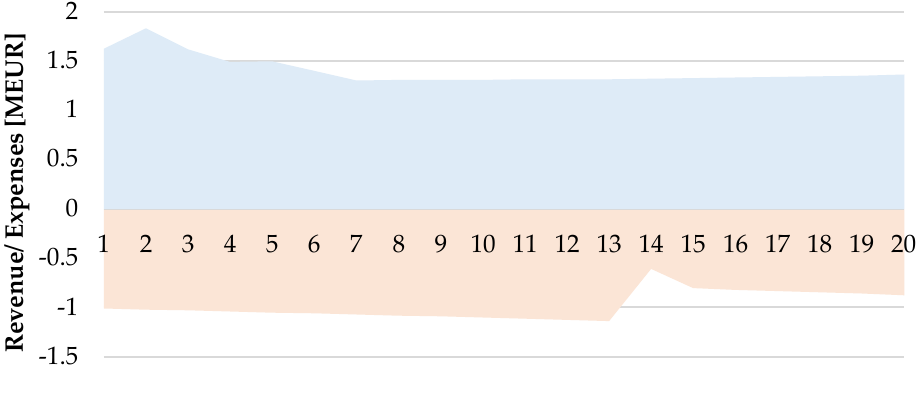
Figure 7. The amount of revenue and expenses of the SOFC unit.